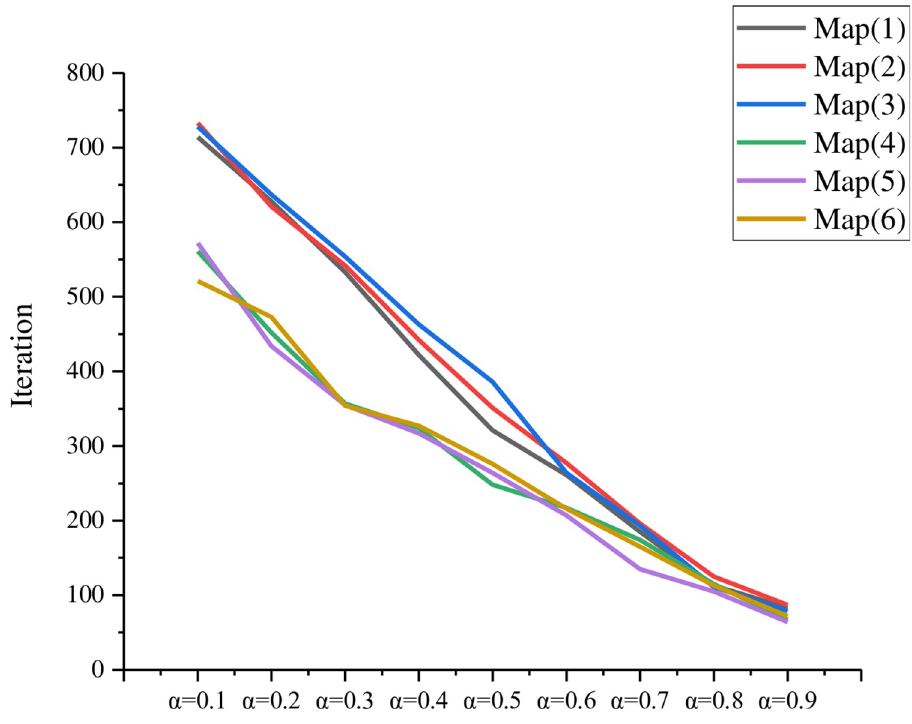
Fig 7. Iteration times with different learning